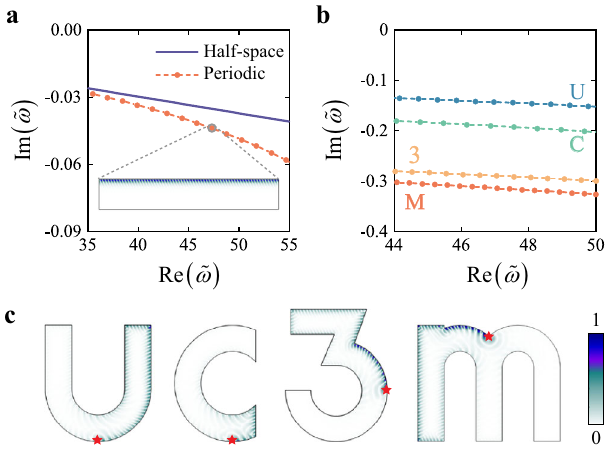
Fig. 4 Rayleigh waves in bound media. a Calculated eigenfrequencies e ω (dots) of a fi nite slab with periodic boundary conditions in the horizontal directions compared to the theoretical solution (solid line) of a half-space. Inset: one representative Bloch wave fi eld at the selected point. b Eigenfrequencies of individual letters (numerically calculated), i.e., "UC3M" as depicted below. c Simulated displacement fi elds when the letters are excited by local vibrations (red stars, ω = 15 π ). In the calculation, the parameters are speci fi ed as α = 1, μ = 0.5, A = 0, and K o = 0.5, and the wave fi elds are normalized with regard to their own maximum